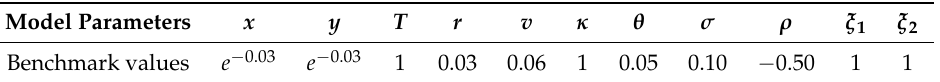
Table 1. Benchmark values of model